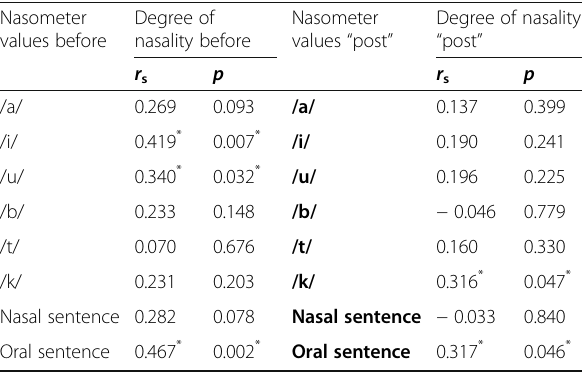
Table 9 Correlation between degree of nasality and nasometer values before and after the